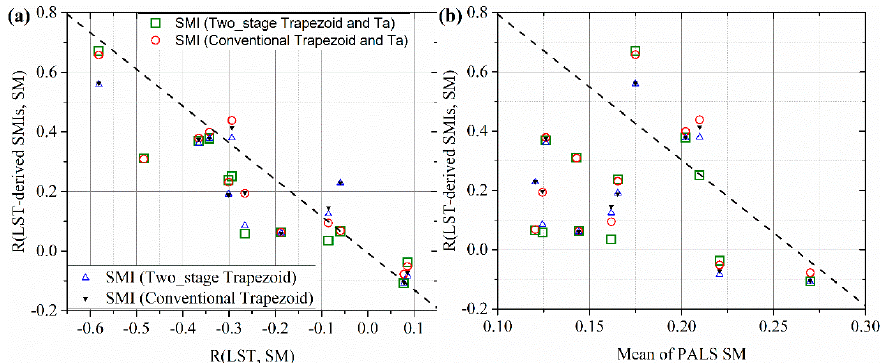
Figure 10. Evaluating the influence of SM and LST-SM link on the LST-derived SMI-SM link.